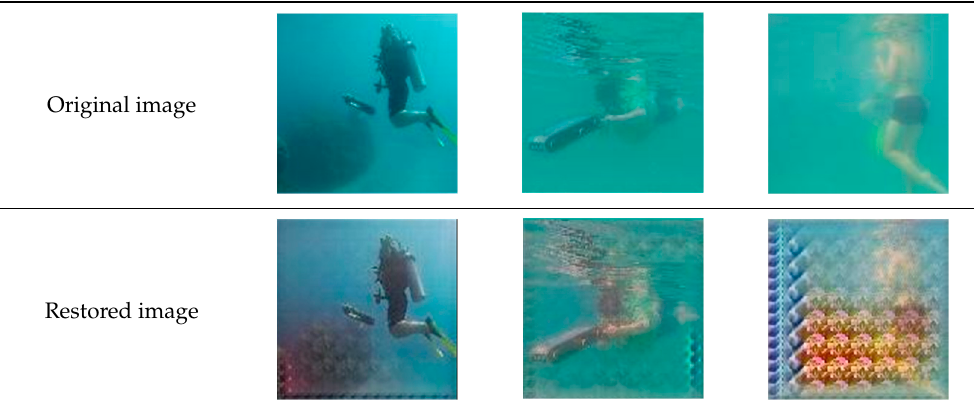
Table 7. Future research will concentrate on restoring blurred images. Table 7. Badly translated images. Table 7. Badly translated images. Table 7. Badly translated images. Table 7. Badly translated images. Table 7. Badly translated Table 7. Badly translated images. Table 7. Badly translated images.